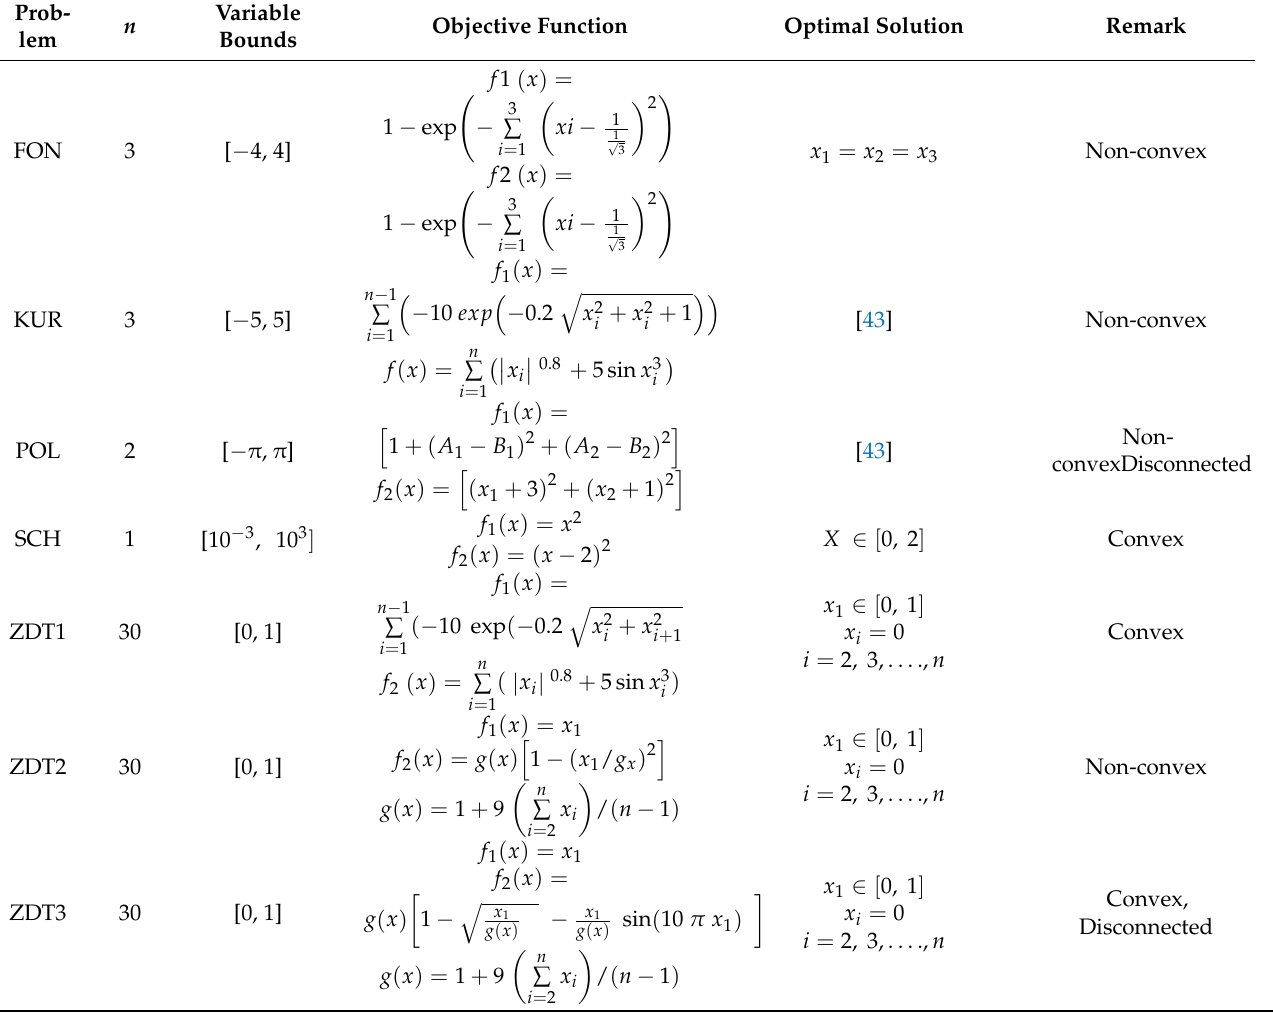
Table 3. Mathematical functions for evaluating MOO